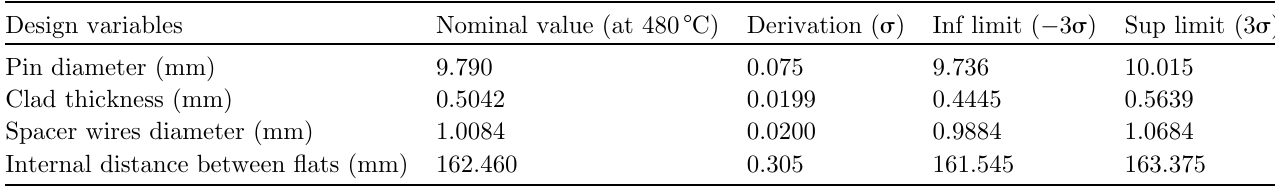
Table 4. Design uncertain variables linked to the core geometry – truncated normal law at ±3 s ⋅ Design variables